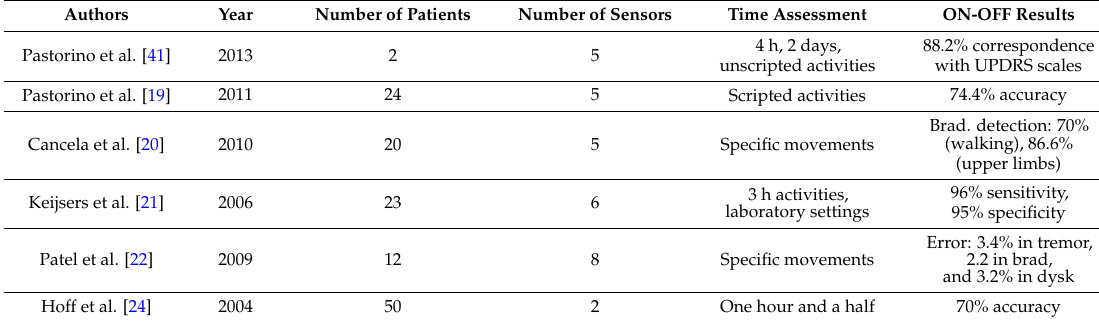
Table 1. Summary of most relevant ON-OFF